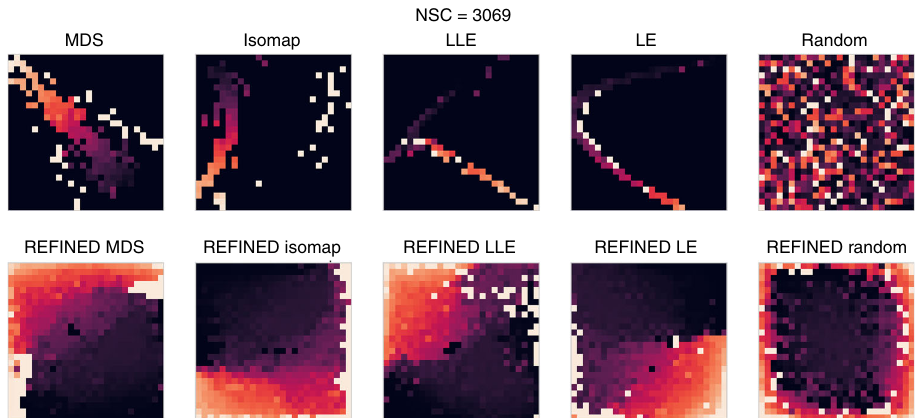
Fig. 4 Example of REFINED images created through different 2D mappings. Illustration of images generated for an example drug from NCI60 using the REFINED approach initialized with different dimensionality reduction techniques, and before (top row) and after (bottom row) applying hill climbing to eliminate feature overlapping.